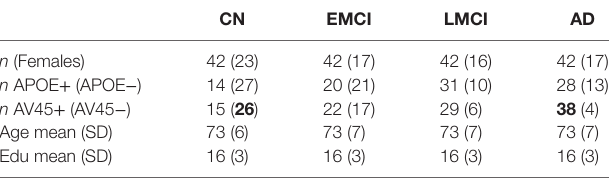
TaBle 1 | Demographics by diagnosis for our anatomical connectome cohort, The168 : 168 ADNI2 participants included in this study. cn eMci lMci aD n